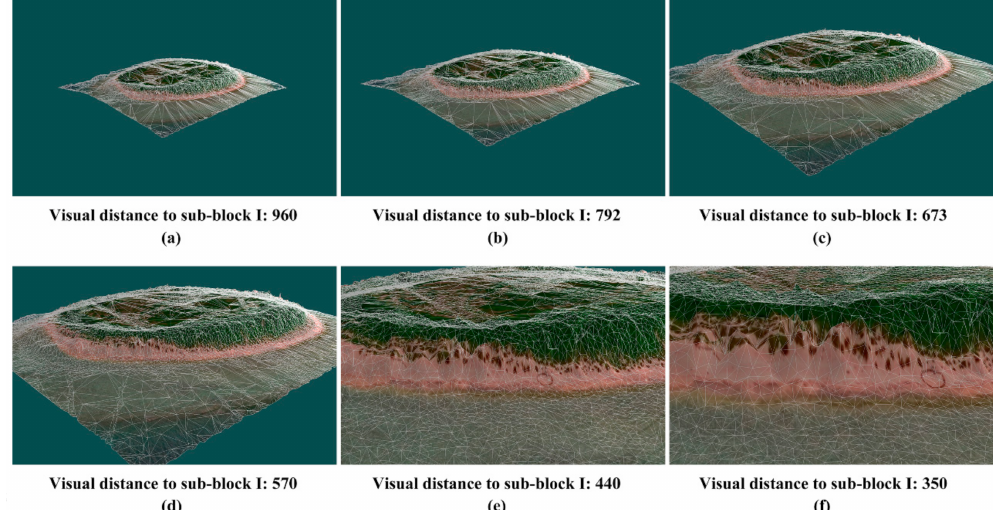
Figure 13. Di ff erent hierarchical models, corresponding to the requirements of di ff erent visual distances. ( a – f ) represent the di ff erent terrain models under di ff erent visual distances. The terrain model in ( a ) is furthest away, and its details are the roughest. The terrain model in ( f ) is the closest and most detailed. As the viewer moves closer to the terrain model, the visual distance decreases continuously, and the corresponding SVO threshold also decreases. The smaller the visual distance, the more detailed the terrain